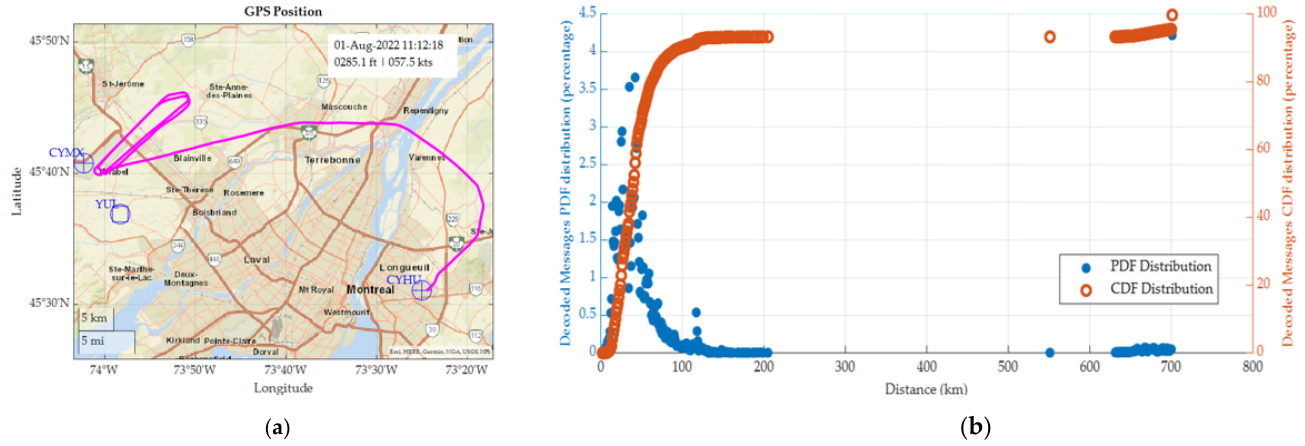
Figure 15. ( a ) Flight test route; ( b ) Percentage of decoded messages distribution in PDF and CDF vs distance in Km.